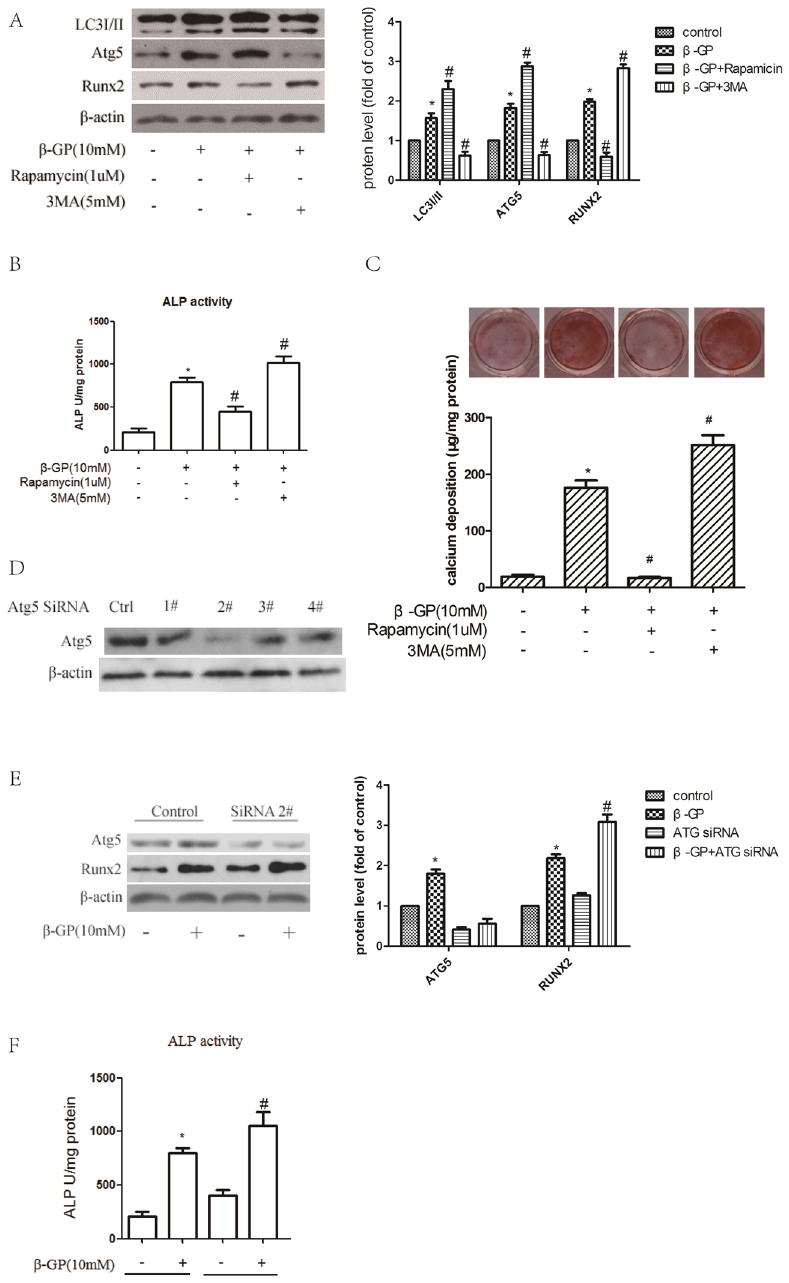
Figure 2. Autophagy plays a protective role in inhibiting the calcification of VSMCs. ( A , B ) VSMCs were pre- treated with the indicated concentrations of 3MA or rapamycin (3MA, an inhibitor of autophagy; rapamycin, an inducer of autophagy) for 30 min and were subsequently incubated with β -GP for 72 h. LC3I/II, Atg5 and Runx2 levels ( A ) and ALP activity ( B ) were detected using Western blot analysis or an ALP kit, respectively. * p < 0.01 compared with the cells treated with vehicle. # p < 0.01 compared with the cells treated with β -GP (n = 5). ( C ) VSMCs were pre-treated with the indicated concentrations of 3MA or rapamycin for 30 min and then incubated with β -GP for 12 days. A representative plate view of the Alizarin Red S staining is shown. Quantification of calcium levels using the O-cresolphthalein complexone method. * p < 0.01 compared with the cells treated with vehicle. # p < 0.01 compared with the cells treated with β -GP (n = 5). ( D ) Western blot analysis of Atg5 protein levels in VSMCs transfected with siRNA against Atg5 (Atg5 1#, Atg5 2#, Atg5 3# and Atg5 4#) or scrambled control for 48 h. ( E , F ) VSMCs were transfected with control or Atg5 2# siRNA for 48 h and treated with or without β -GP for 72 h. Western blot analysis of Atg5 and Runx2 protein levels ( E ) and ALP activity detection ( F ) were performed. * p < 0.01 compared with the cells treated with vehicle in the control group. # p < 0.01 compared with the cells treated with vehicle in the ATG5 siRNA group (n = 5). Representative images are